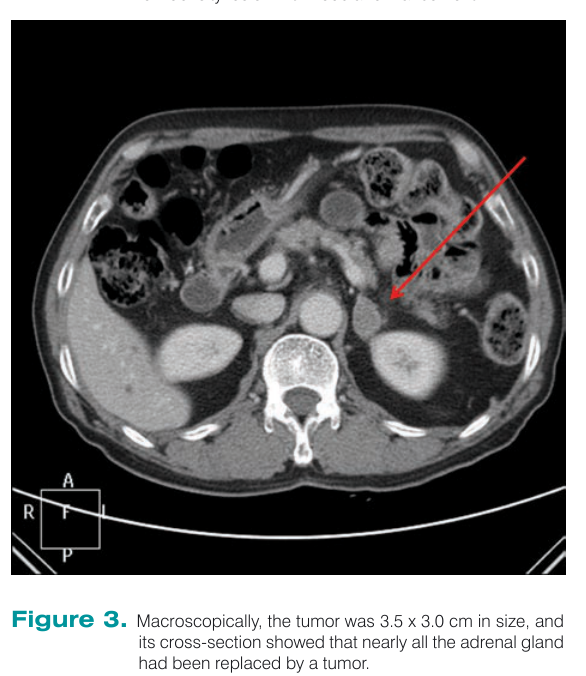
Figure 1. Enhanced computed tomography showed 2.5 cm sized low density lesion with nodular enhancement.